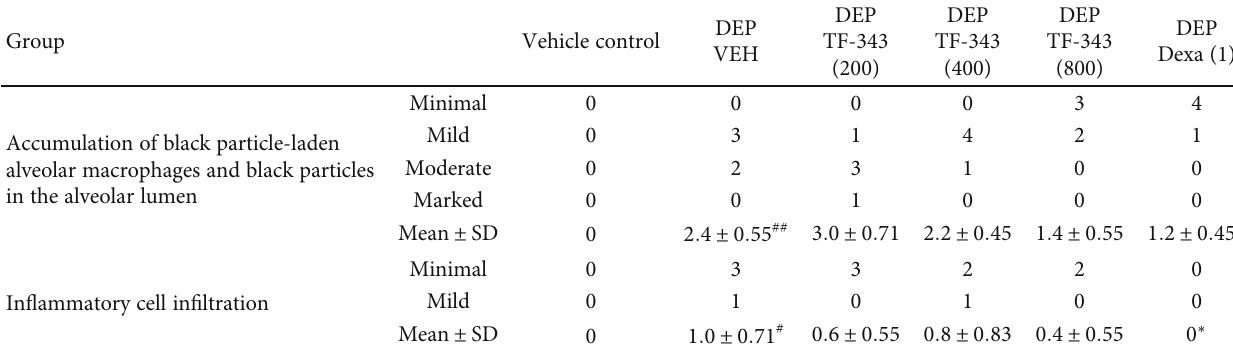
Table 1: Quantitative histopathological assessment of lung sections.